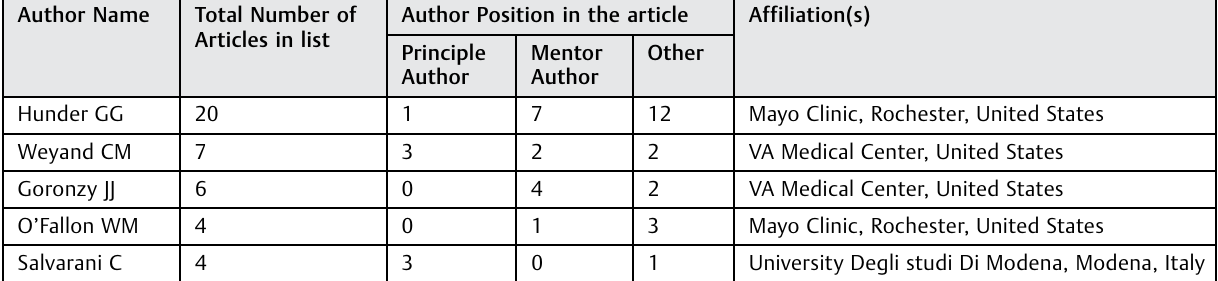
Table 2 Top ranked authors with 4 or more publication within the list of top-50 most in fl uential articles on GCA